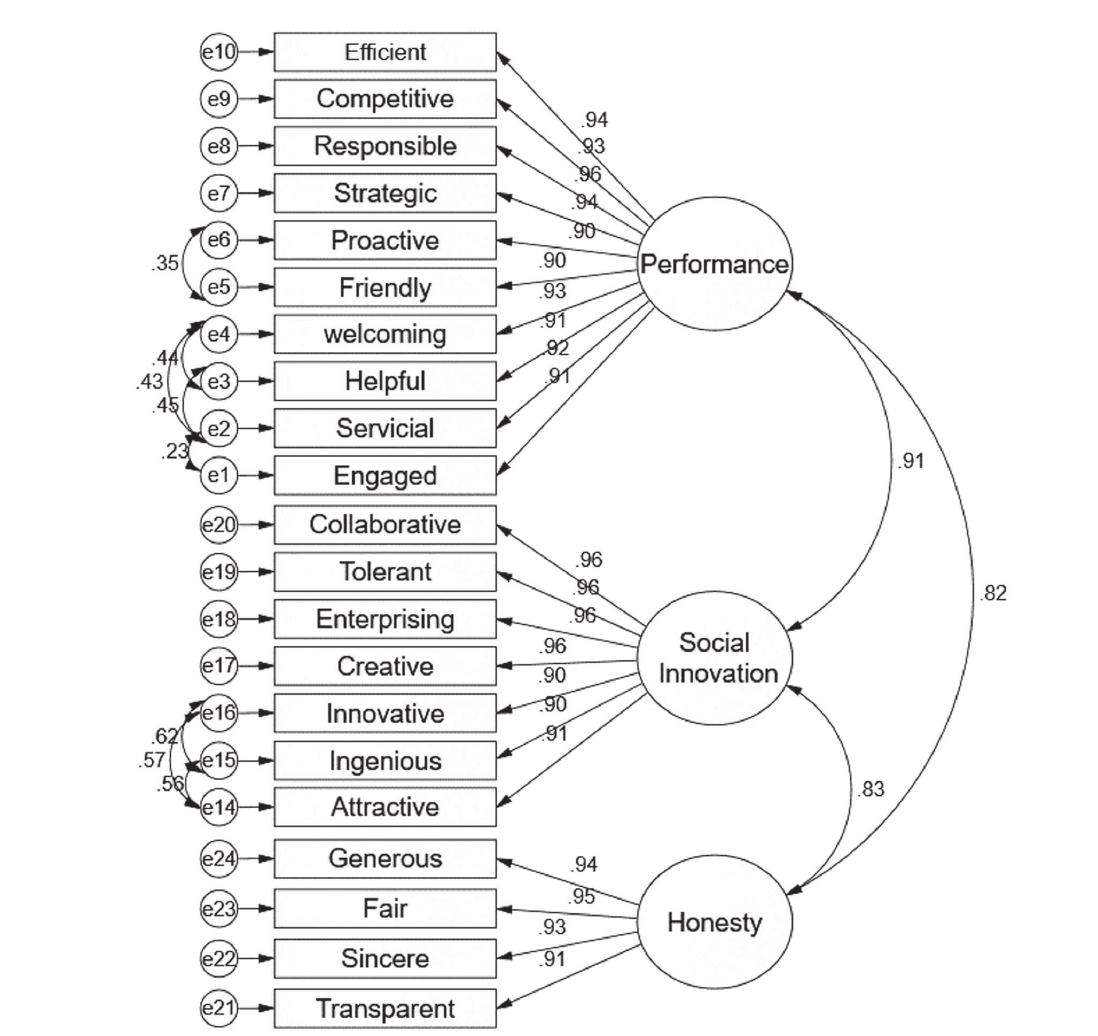
Figure 1. Three-dimensional confirmatory model of the BPTD